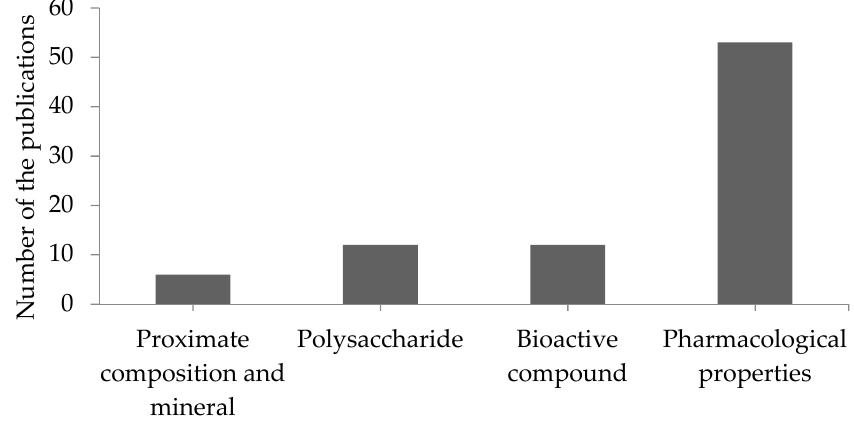
Figure 2. The number of publications related to the nutritional and pharmacological properties of H. fusiformis.